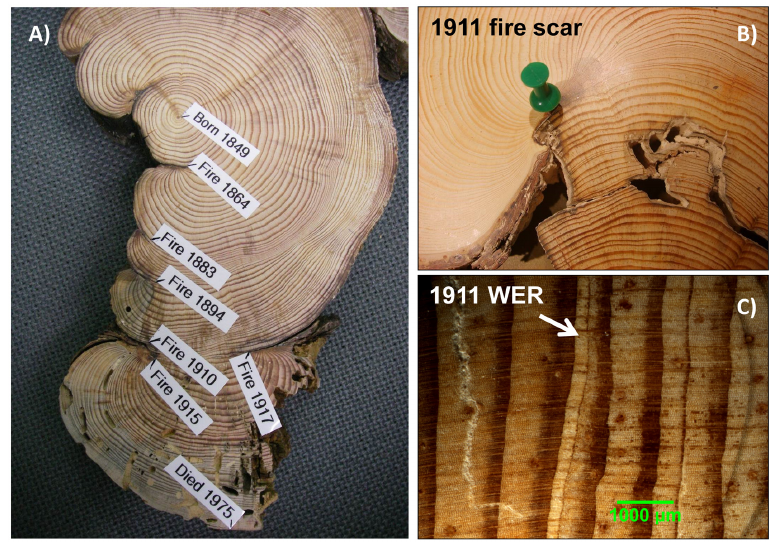
Figure 3. Pinus banksiana cross-section presenting six fire scars ( A ); P. banksiana cross-section showing a fire scar in 1911 ( B ), and another one showing a white earlywood rings (white arrow) in 1911 ( C ).